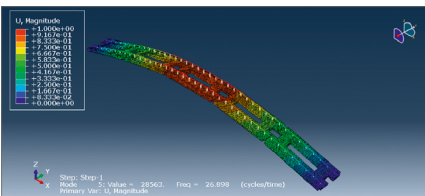
Figure 8: Modes of vertical and lateral torsional modes of track plates.